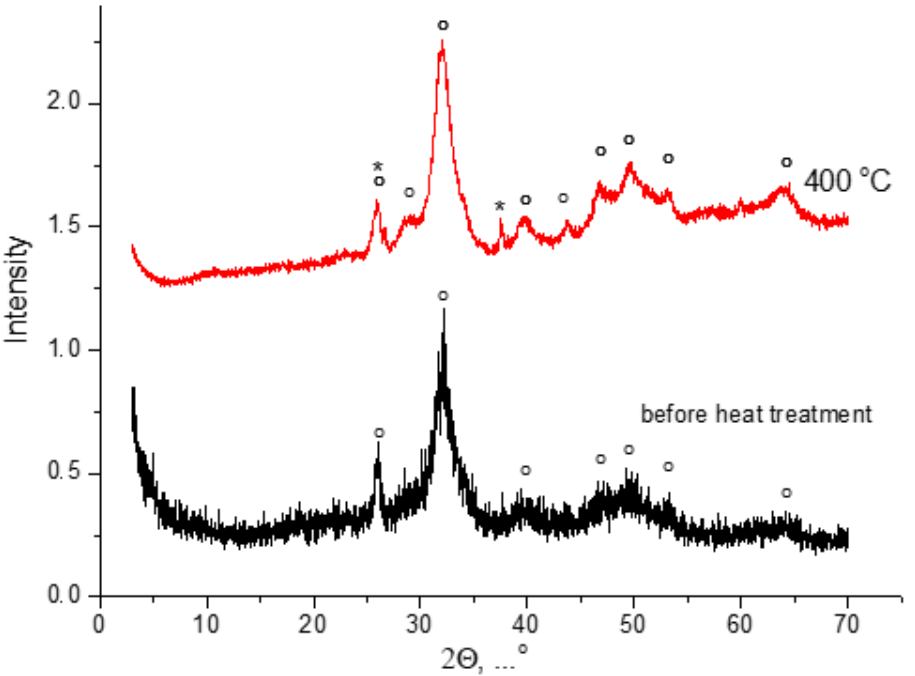
Figure 6. XRD data of powders enriched with inorganic components prepared from the mixture of fish scales using high-speed grinding and vibration sieving before and after heat treatment at 400 ◦ C: o— Ca 10 (PO 4 ) 6 (OH) 2 (PDF card #9-432; *—Ca 2,82 Mg 0,19 (PO 4 ) 2 (PDF card #70-682) or Ca 18 Mg 2 H 2 (PO 4 ) 14 (PDF card